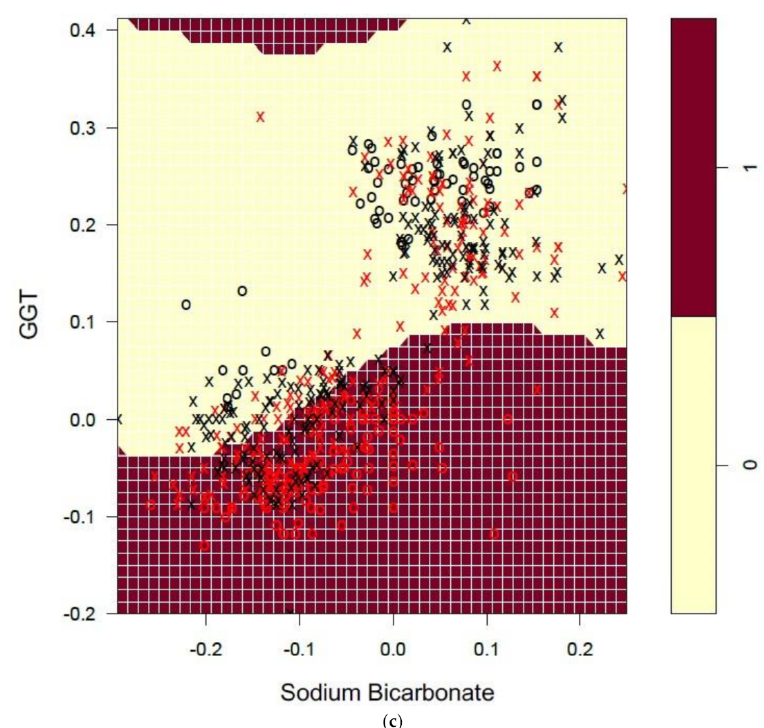
Figure 2. Plots summarizing the recursive partitioning and support vector machine (SVM) analyses of EQA relative deviation prediction of NATA Minor Class Condition reports by electrolyte-creatinine data (and GGT). ( a ) Random Forest; ( b ) Single Decision Tree and ( c ) SVM model. Features of the random forest modelling are presented in Table 2. For SVM, only GGT and sodium bicarbonate were included in the final model. Low NATA Class (Yellow); High NATA